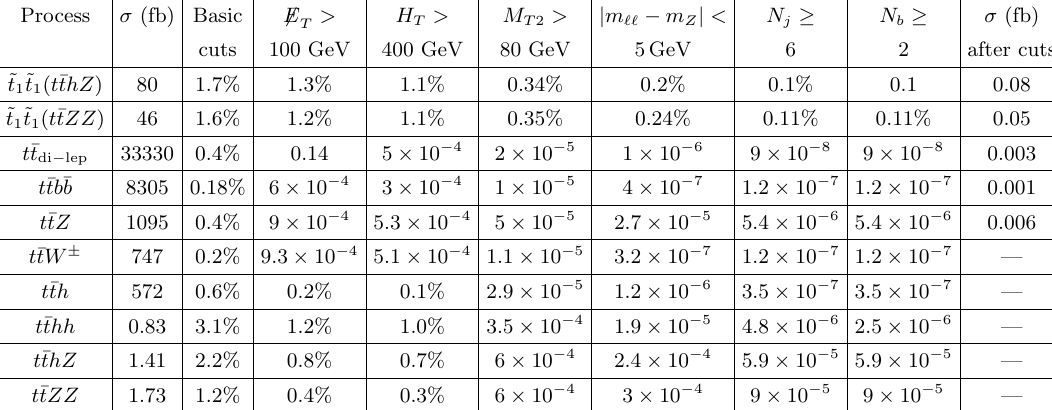
Table 6 . Cumulative cut e(cid:14)ciencies after each level of advanced selection cuts and cross sections t (cid:22) thZ E E for the signal ~ t 1 ~ t (cid:3) and t (cid:22) tZZ as well as SM backgrounds in the 2 OS ‘ signal region at T T 1 ! 6 6 E the 14 TeV LHC. t (cid:22) thh is not listed here due to the small signi(cid:12)cance. Note that only dileptonic T 6 decay of t (cid:22) t is in used this